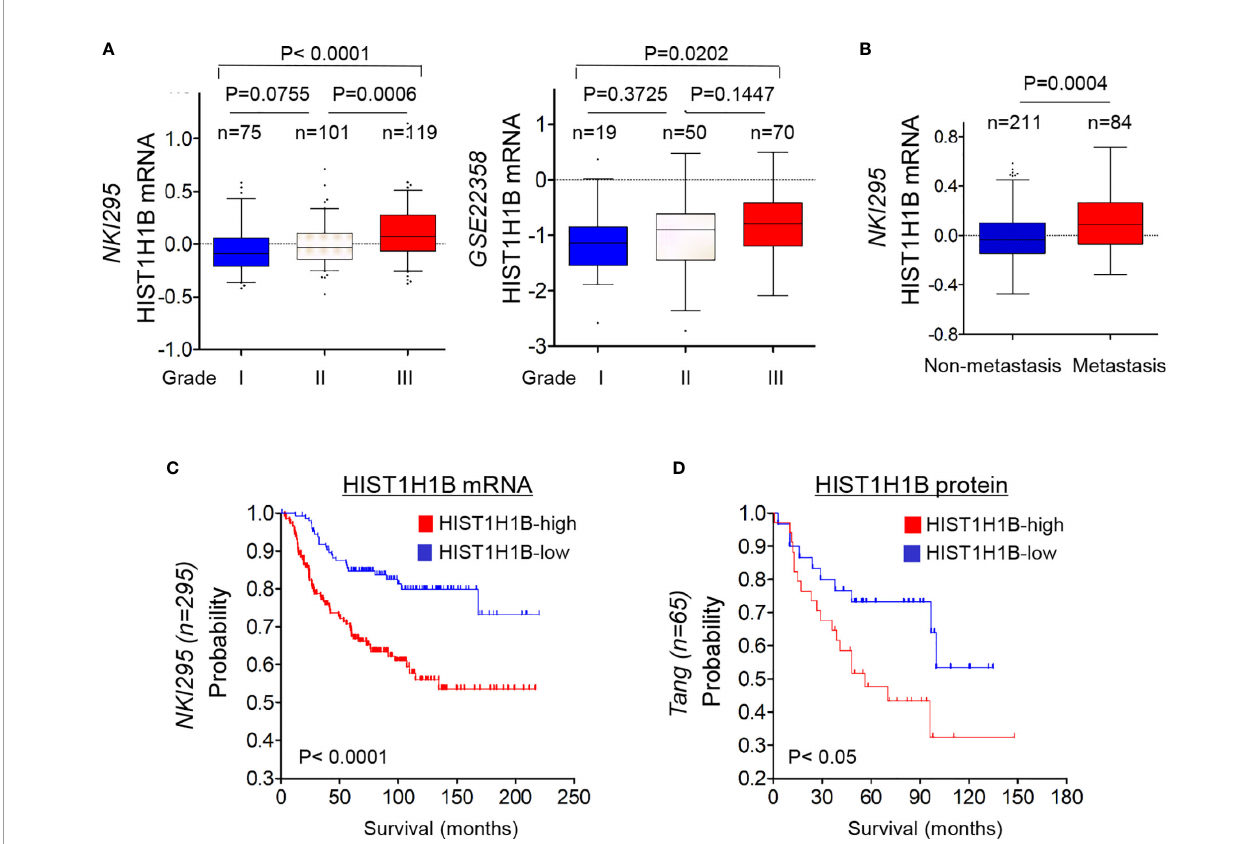
FIGURE 6 | HIST1H1B overexpression associates with higher tumor grade, higher probability of metastasis, and poorer survival of breast cancer patients. (A) Box- plots indicated HIST1H1B expression in different histological grades of breast cancer from NKI295 and GSE22358 datasets. Comparisons between two groups are made using the two-tailed Student's t-test. (B) Analysis of HIST1H1B expression in breast cancer patients with or without metastasis from the NKI295 dataset. (C, D) Kaplan-Meier survival analysis for DMFS of patients in NKI295 and Tang's datasets according to HIST1H1B expression status. The p-value is determined using the log-rank